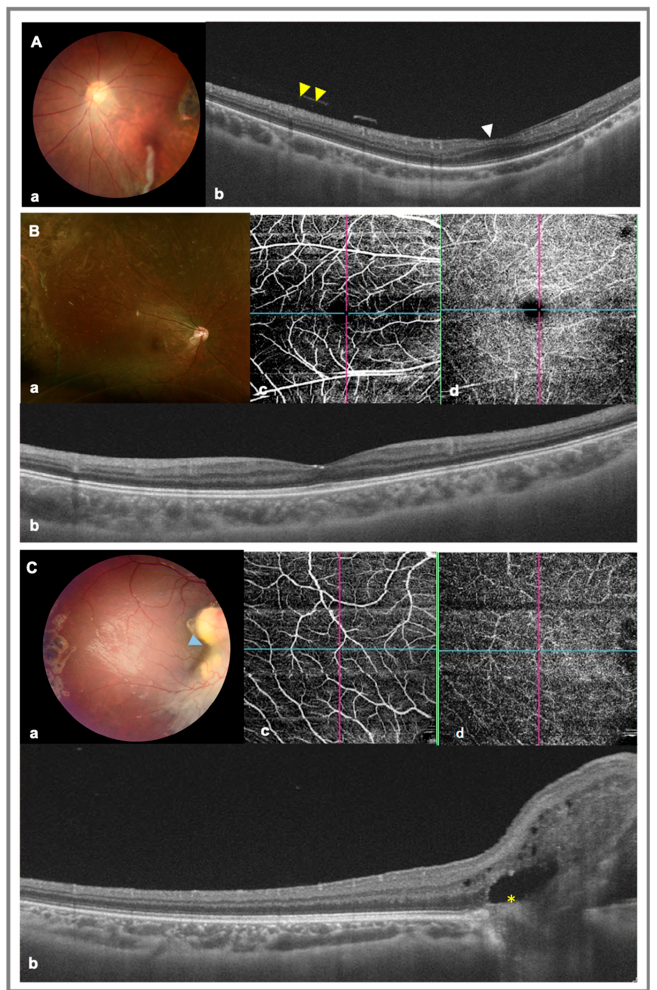
Figure 2. OCT and OCTA images of familial exudative vitreoretinopathy (FEVR). ( A ) A 26-year-old female with bilateral FEVR with a left eye best corrected visual acuity of 0.03. ( A ( a )) Color fundus photography of the left eye showing straightened vessels with peripheral avascular retina and two fibrovascular patches superior and inferior to the macula. ( A ( b )) The corresponding macula OCT shows a thickened posterior hyaloid (yellow arrow) and foveal hypoplasia (white arrow). ( B ) A 20-year-old woman with bilateral congenital cataract and right eye FEVR-related retinal detachment status after combined scleral buckling and pars plana vitrectomy when she was 11 years of age. The best corrected visual acuity was 0.7. ( B ( a )) Ultrawide field color fundus photograph of a right eye 9 years after surgery showing laser photocoagulation scars temporally. ( B ( b )) The corresponding macula OCT image showing foveal hypoplasia (white arrow). ( B ( c , d )) OCTA image showing a smaller FAZ on the superficial capillary plexus (SCP) and deep capillary plexus (DCP), and vessel straightening on the SCP slab. ( C ) An 8-year-old boy with a history of bilateral FEVR that received right eye laser photocoagulation temporally when he was 3 years of age. The best corrected visual acuity was 0.02. ( C ( a )) Color fundus photography of the right eye showing a fibrovascular stalk at the nasal retina and optic disc causing optic nerve head dragging (blue arrow). ( C ( b )) The corresponding macula OCT image showing vitreopapillary traction, a subpapillary cystic space (yellow asterisk) and foveal hypoplasia. ( C ( c , d )) OCTA image showing the absence of the FAZ and decreased vessel density in the SCP and